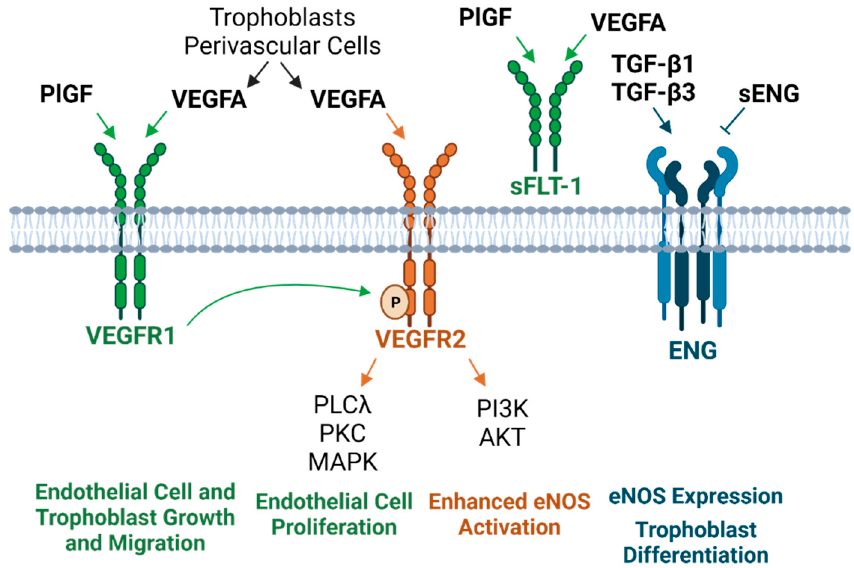
Figure 3. Circulating and placenta-derived vascular substances associated with preeclampsia and their downstream cellular effects [54,101,102,104–107,114,115,122,123,125,126,130,131,133]. PlGF, VEGFA, and ENG are considered “proangiogenic” factors, whereas sFLT-1 and ENG are “antiangiogenic.” sFLT-1 sequesters PlGF and VEGFA, and sENG blocks TGF- β binding to the ENG receptor (PlGF, placental growth factor; VEGFA, vascular endothelial growth factor A; sFLT-1, soluble fms-like tyrosine kinase 1; ENG, endoglin; sENG, soluble endoglin; VEGFR1 and VEGFR2, vascular endothelial growth factor receptor 1 and 2; TGF- β , transforming growth factor-beta; PLC λ , phospholipase C gamma; PKC, protein kinase C; MAPK, mitogen-activated protein kinase; PI3K, phosphatidylinositol 3-kinase; AKT, protein kinase B; eNOS, endothelial nitric oxide synthase).